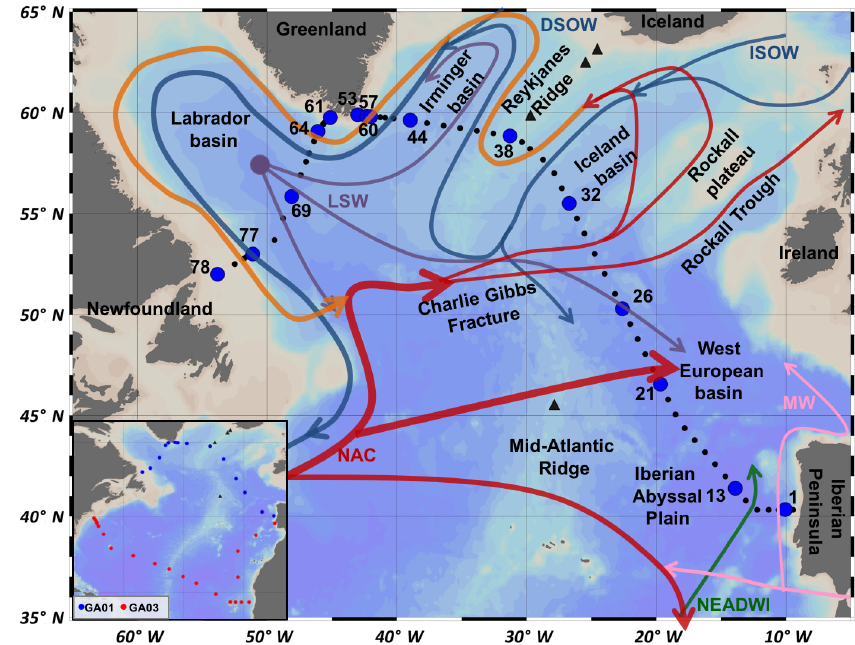
Figure 1. Station locations of the GA01 section between Portugal and Newfoundland in the North Atlantic (black and blue dots). Stations investigated for 226 Ra and Ba are marked as blue dots. The main currents and water masses in the North Atlantic are also represented. The major hydrothermal vents located near the GA01 section are indicated by black triangles. Stations investigated during the US-GEOTRACES- GA03 section, also conducted in the Atlantic Ocean, are reported on the lower panel (red